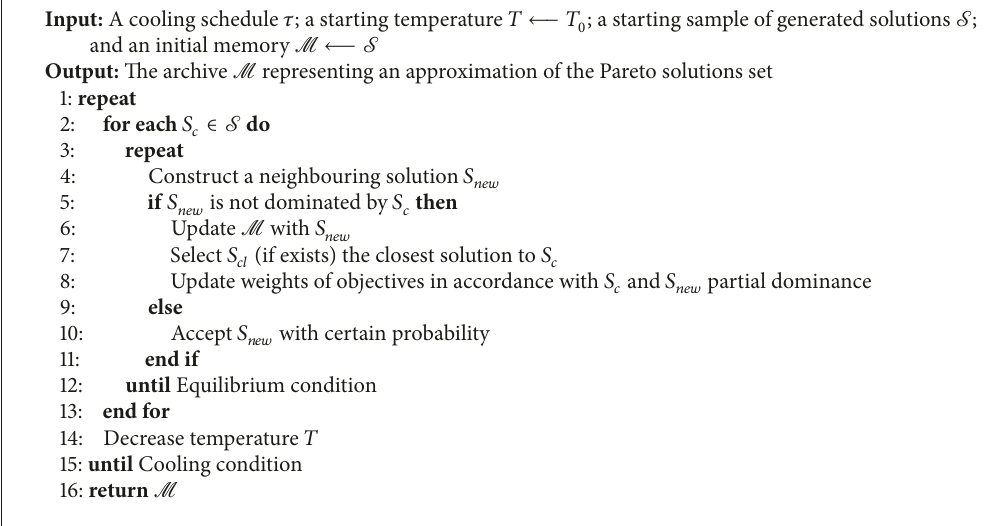
Algorithm 1: PSA procedure.